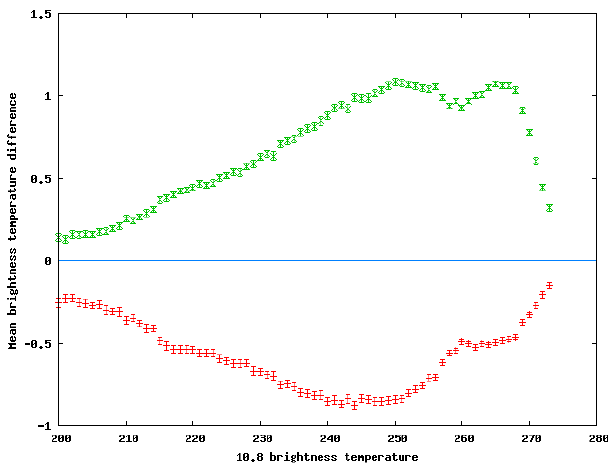
Figure 2.b. Difference of the mean value of 6.2 µm and 7.3 µm channels between non rainy and rainy Fig. 2b. Difference of the mean value of 6.2µm and 7.3µm channels pixels plotted versus 10.8 µm brightness temperature in red and green respectively. Curves are plotted between non rainy and rainy pixels plotted versus 10.8µm bright- with error-bars. Both scales are in Kelvin. ness temperature in red and green, respectively. Curves are plotted with error-bars. Both scales are in Kelvin.